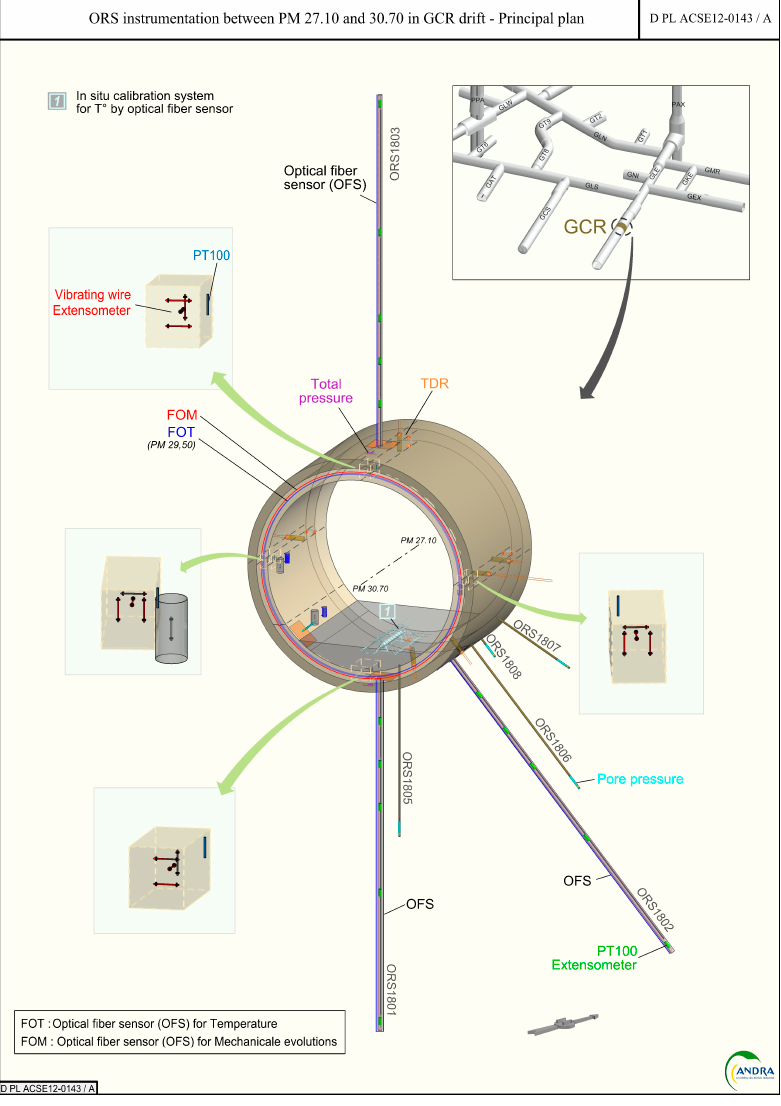
Figure 10. Schematic view of the monitoring section in the GCR gallery and pictures of implemented sensors, including optical fibre sensors. sensors, including optical fibre